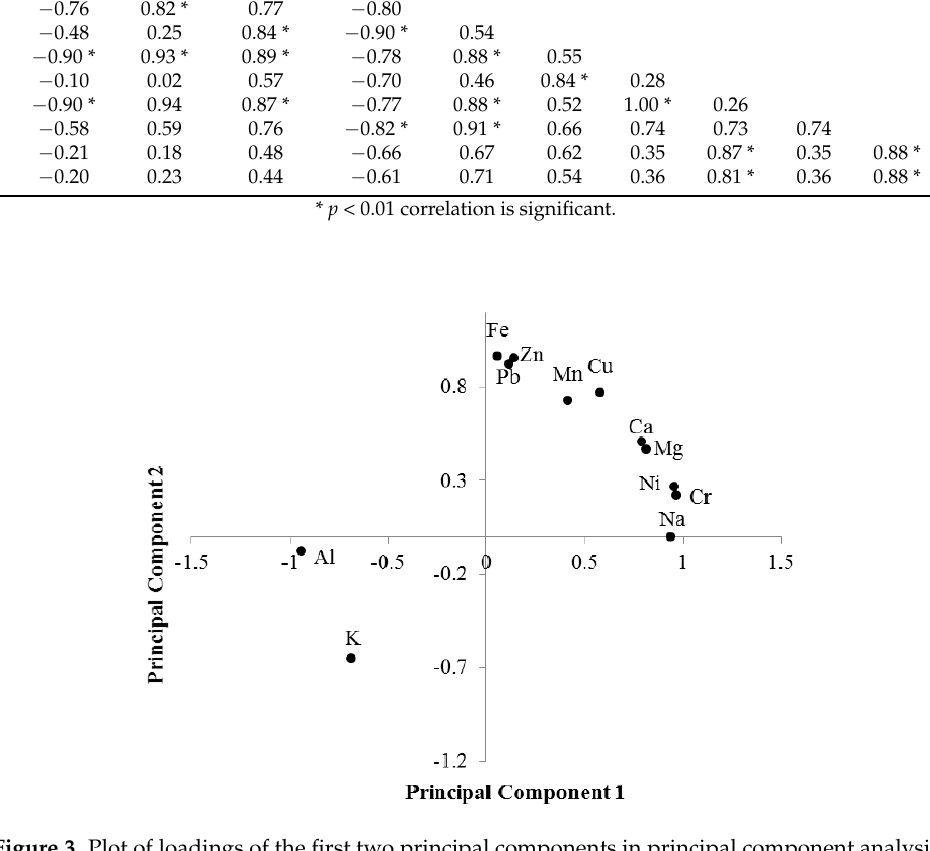
Figure 3. Plot of loadings of the first two principal components in principal component analysis.